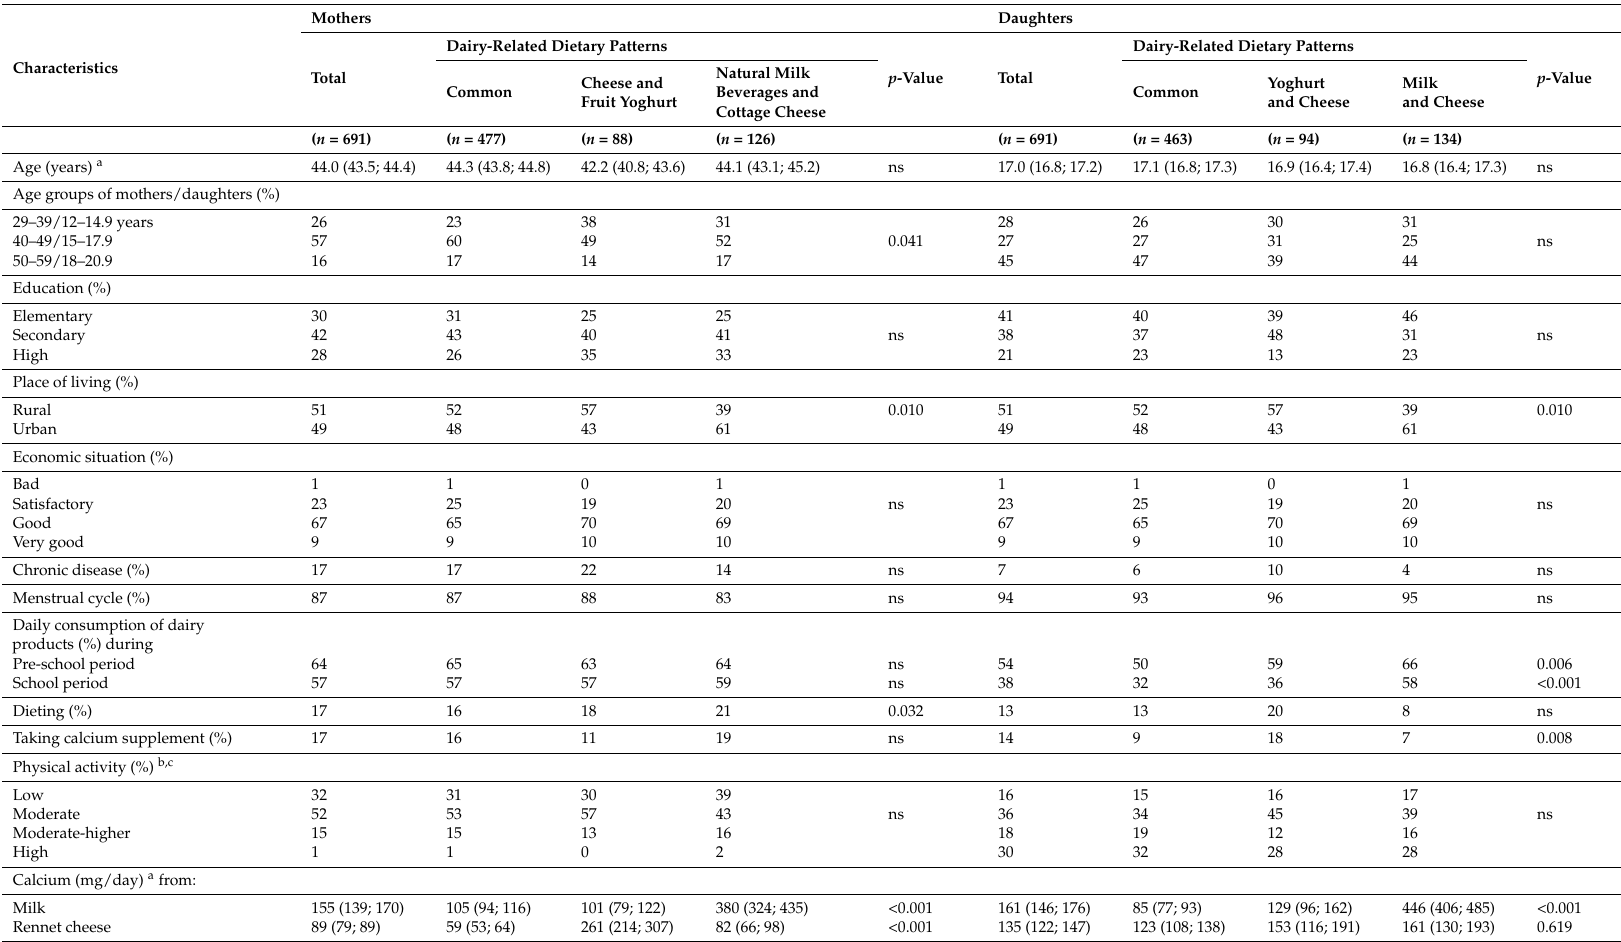
Table 1. Sample characteristics by dairy-related dietary patterns (percent or mean with 95% confidence